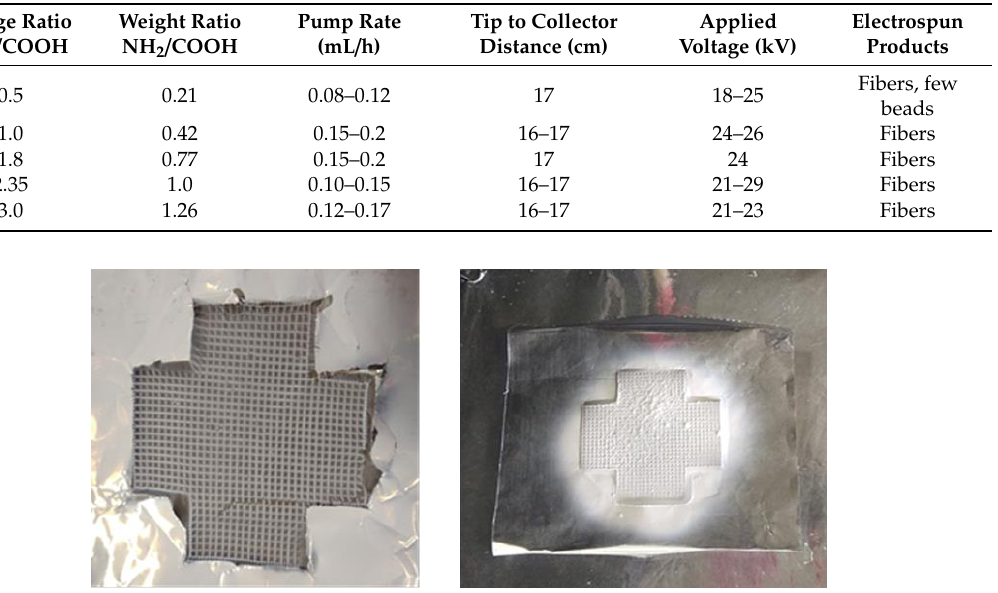
Table 2. Experimental Conditions for Electrospinning.